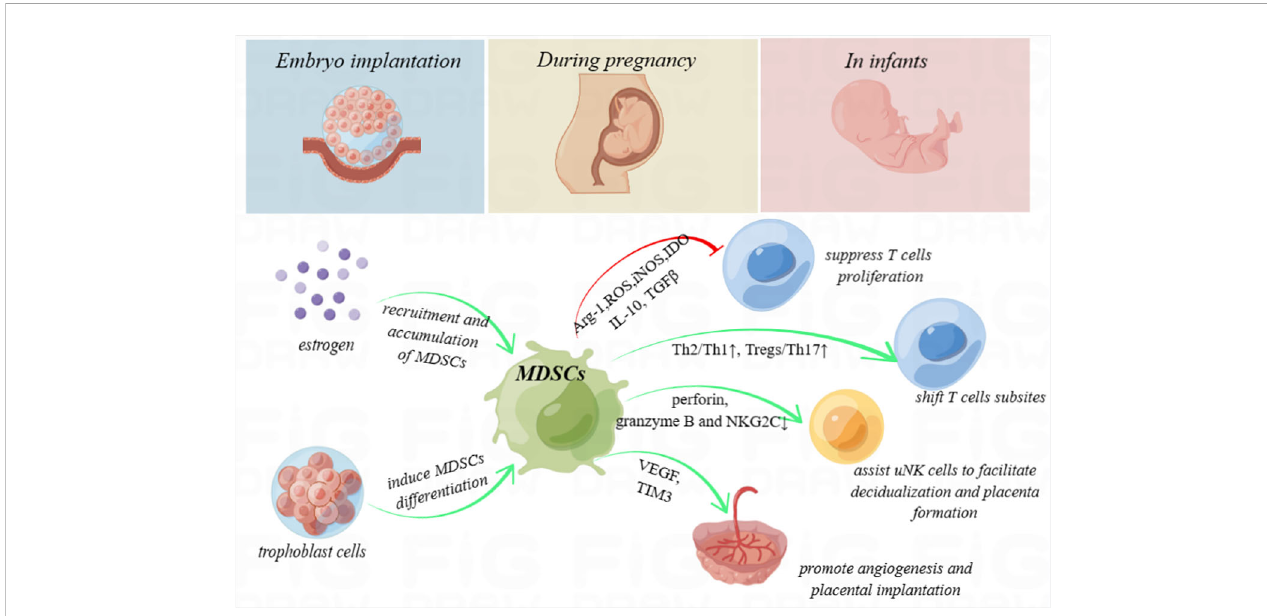
FIGURE 1 Schematic diagram. Myeloid-derived suppressor cells (MDSCs) secrete high levels of immunosuppressive products, including arginase-1 (Arg-1), reactive oxygen species (ROS), inducible nitric oxide synthase (iNOS), and indoleamine-2,3-dioxygenase (IDO), and produce anti-in fl ammatory cytokines, such as interleukin 10 (IL-10) and transforming growth factor beta (TGF- b ), with the ability to inhibit T-cell proliferation. In addition, MDSCs shift the T helper (Th) 1/Th2 cell and Th17/regulatory T cell (Treg) subsets to exert immunoregulation function. They also enhance uterine natural killer (uNK) cells to facilitate decidualization and placenta formation by downregulating perforin and granzyme B in the cytoplasm and NK group protein 2 D ‐ activating NK receptor (NKG2C) on the cell surface and promote angiogenesis and placental implantation through the VEGF and TIM3 pathway. During pregnancy, high levels of estrogen and trophoblasts may recruit, accumulate, or even induce the differentiation of MDSCs. MDSCs de fi ciency is considered to be associated with embryo implantation failure, spontaneous miscarriage, intrauterine growth restriction, and preeclampsia. Furthermore, MDSCs even play crucial roles to enhance immune tolerance in